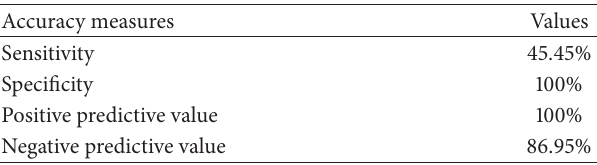
Table 3: Accuracy parameters of the RDT using the slide microscopy as gold